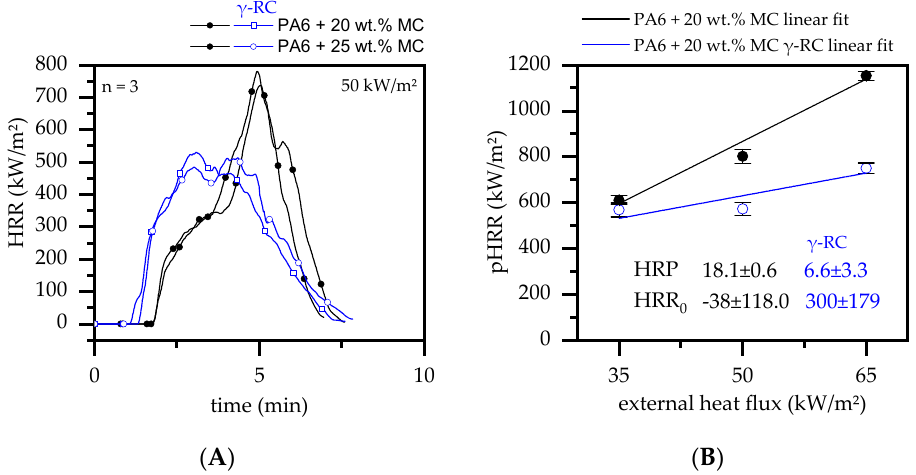
Figure 11. ( A ) HRR curves conducted by cone calorimeter testing for net and β -radiation β -RC PA6/MC formulations at 50 kW/m 2 . ( B ) pHRR conducted by cone calorimeter tests at external heat fluxes of 35, 50 and 65 kW/m 2 . A linear fit was used to evaluate the HRP and corresponding y-cross point HRR 0 .